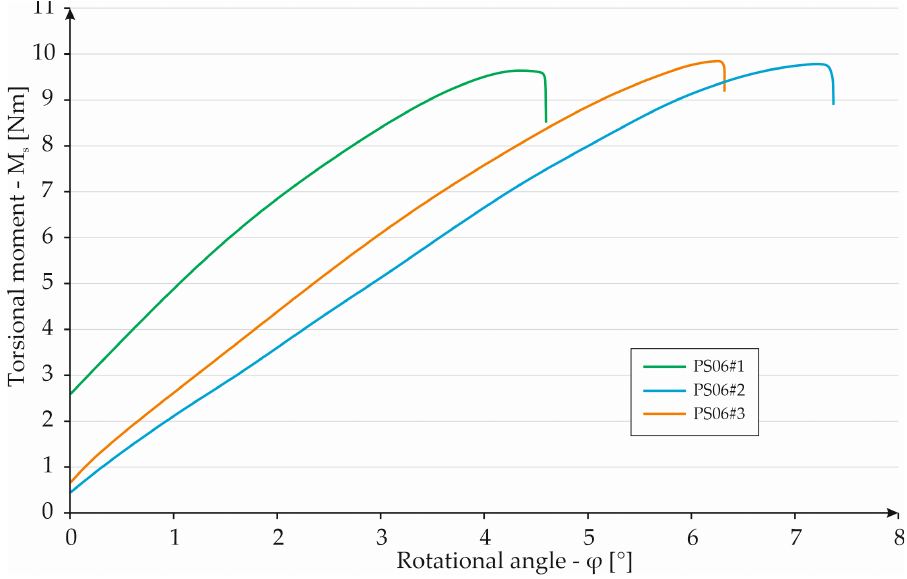
Figure 14. Graph showing the dependence of torque on torsion angle for PS06 specimens. Sample S08#1 reached an angle of 7.3° at a torsional torque of 21 Nm. Specimen S08#2 failed at the highest value of the torsional moment. In this case, its value was 21.6 Nm, which corresponds to an angle of 7.8°. The last case retained the lowest torsion strength. Specimen S08#3 broke at an angle of 7.5° with a torsional moment of 20.3 Nm. All curves are similar to each other which indicates repeatability of all parts’ properties. The angle of twist was between 7.3° and 7.8° with a torsional torque of 21 Nm and 21.6 Nm. The results are shown in Figure 15.